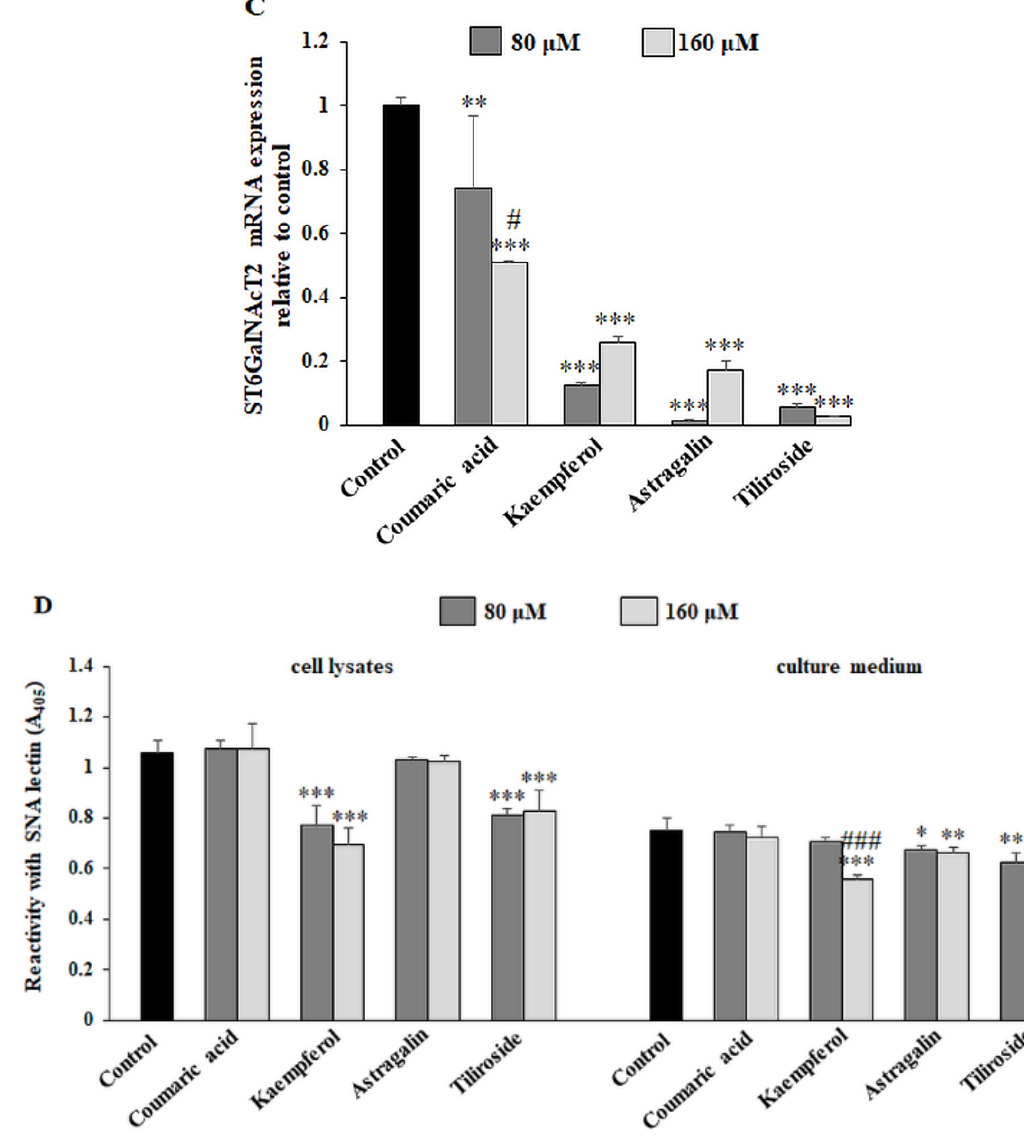
Figure 4. The effect of coumaric acid, kaempferol, astragalin and tiliroside on ppGalNAcT2 mRNA, Tn antigen in cell lysates and culture medium, ST6GalNAcT2 mRNA, and sialyl Tn antigen expression in cell lysates and culture medium. The AGS cancer cells were incubated for 24 h with 80 and 160 µ M concentrations of the polyphenolics. mRNA was determined by RT-PCR (( A ) for ppGalNAcT2 and ( C ) for ST6GalNAcT2). The results are shown as a relative fold change in mRNA expression of genes in comparison to the genes in control where expression was set at 1. ± SD are the mean of triplicate cultures. * p < 0.05, ** p < 0.01, *** p < 0.001 compared to untreated control; # p < 0.05 compared to lower concentration (80 µ M) of specific polyphenolic compound. Tn and sialyl Tn antigens’ relative expressions in cell lysates and culture medium were analyzed by ELISA tests with biotinylated lectins (VVA recognizing Tn structure ( B ) and SNA recognizing sialyl Tn antigen ( D )). The results are expressed as absorbance at 405 nm after reactivity with proper lectin. Values ± SD are the mean from three independent assays. * p < 0.05, ** p < 0.01, *** p < 0.001 compared to untreated control; # p < 0.05, ### p < 0.001 compared to lower concentration (80 µ M) of specific polyphenolic